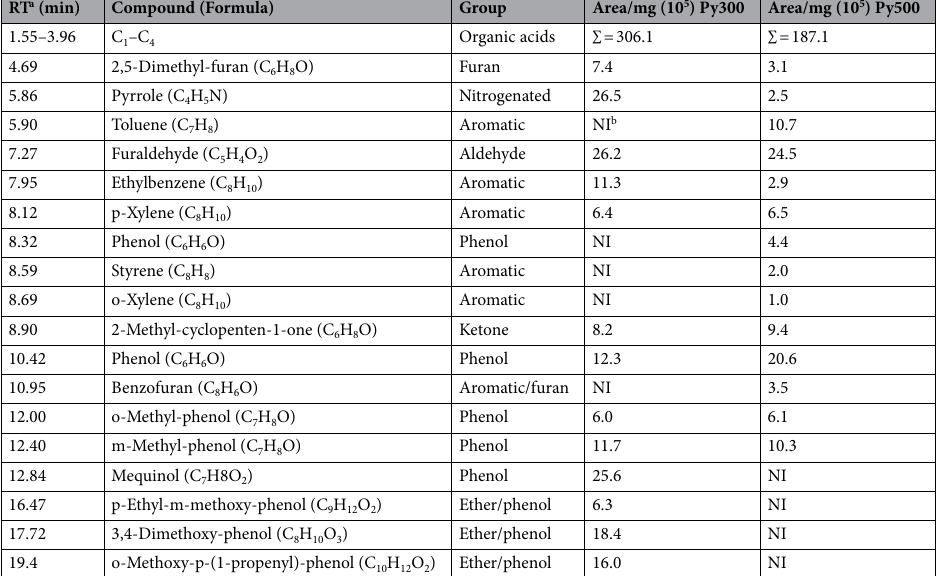
Table 4. Thermal pyrolysis products for 300 and 500 °C. a Retention time (min). b Not identified.